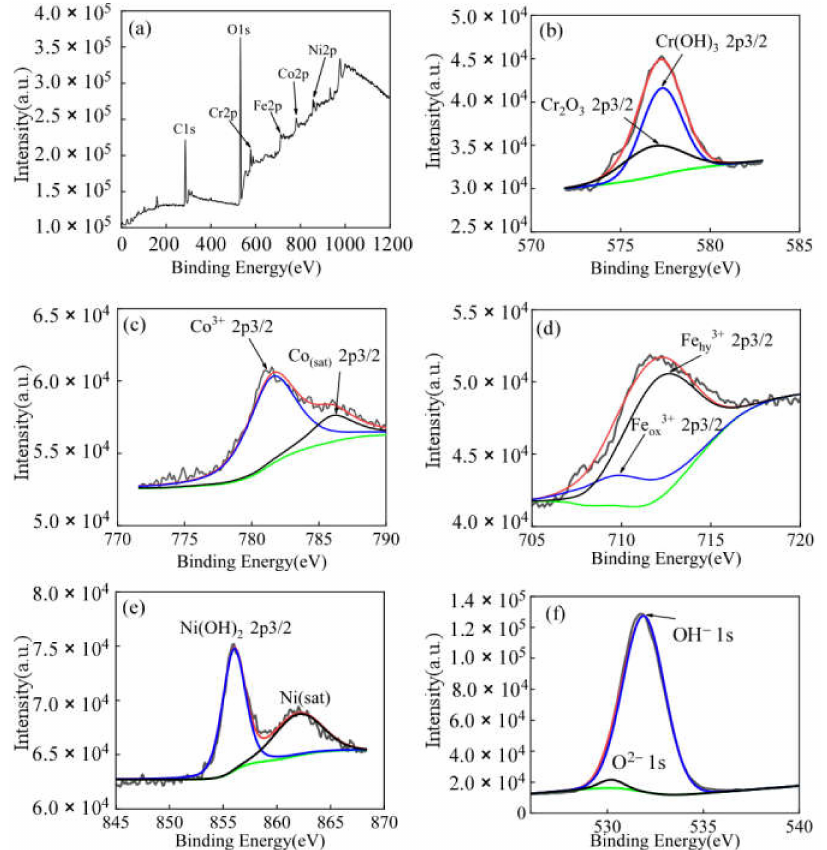
Figure 10. High-resolution XPS pattern of the passivation film on FeCoNiCrBSiY coating in 3.5 wt.% NaCl solution. ( a ) suevey spectrum; ( b ) Cr 2p3/2; ( c ) Co 2p3/2; ( d ) Fe 2p3/2; ( e ) Ni 2p3/2; ( f ) O 1s detail